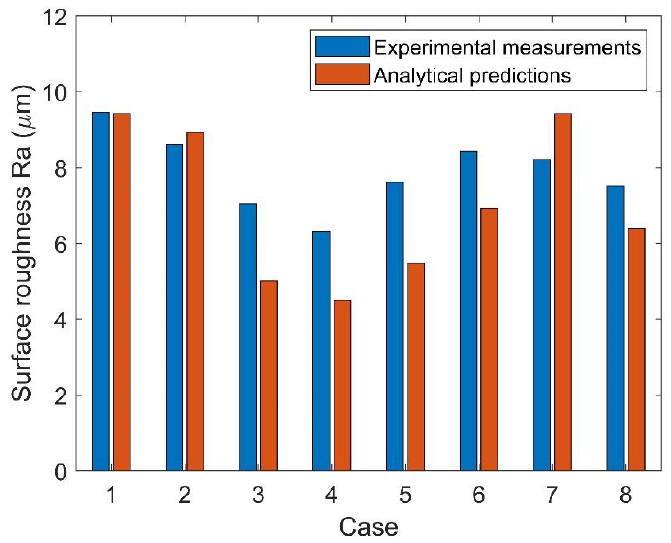
Figure 4. Comparison between predicted and measured surface roughness